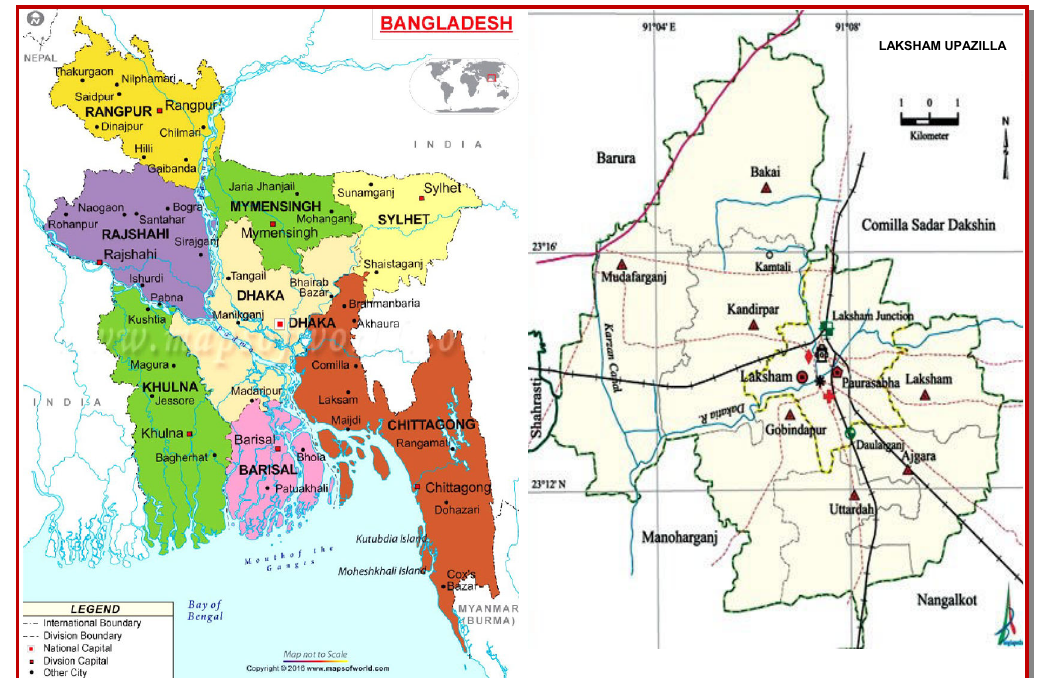
Figure 1: Map of Laksam Upazilla, Kandirpar